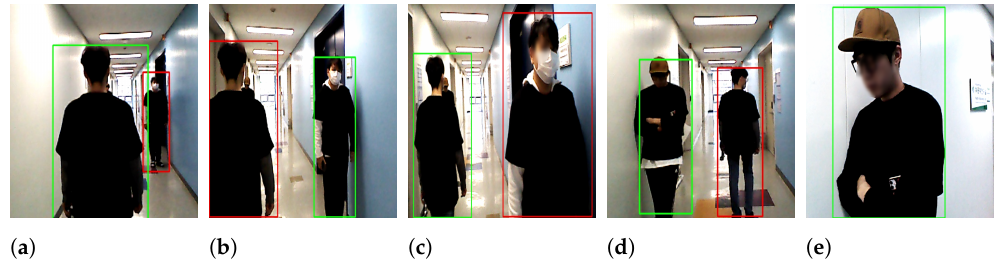
Figure 17. Snapshots of the following failure using only two features of the color and height: robot’s